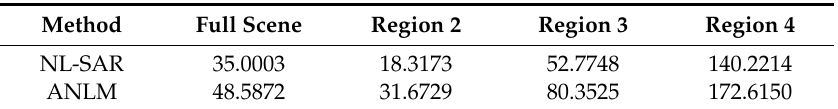
Figure 9. Comparison of the NL-SAR and the ANLM filters by the ENL NLRB . ( a ) The NL-SAR filter. ( b ) The ANLM filter. ( c ) The ENL NLRB difference between the ANLM and the NL-SAR filters. Table 3. Quantitative comparison of the NL-SAR and the ANLM filters by average ENL NLRB on the full scene and the marked regions 2–4 in Figure